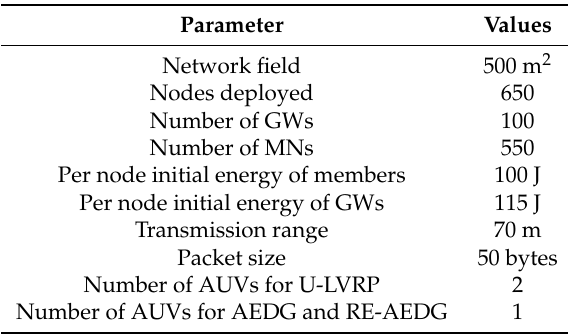
Table 3. Simulation specifications for